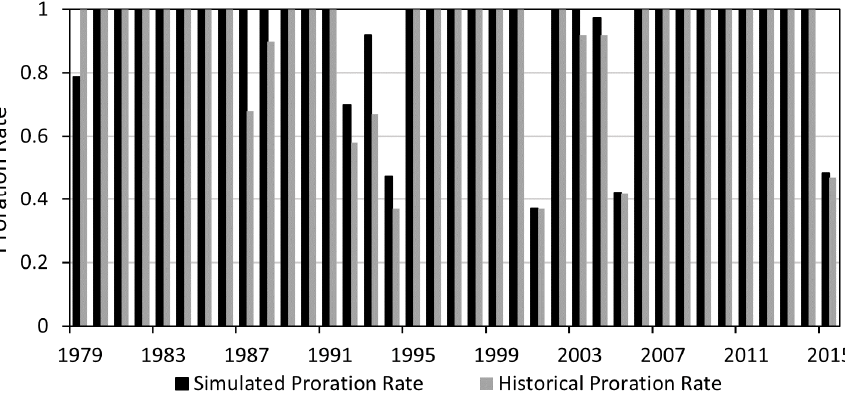
Figure 9. Simulated and historical proration rate during 1979–2015. The historical proration rate was from the YRB project report [52].